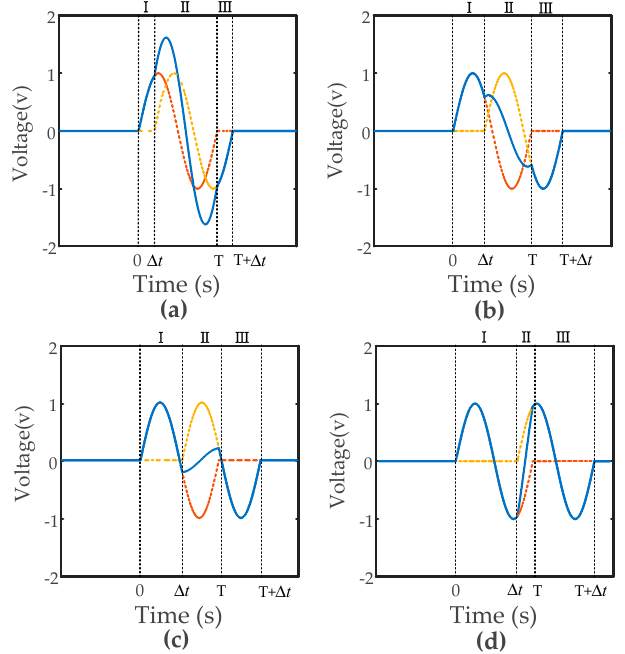
Figure 4. Four typical superposition states: under di ff erent situations: ( a ) ∆ t ∈ [ 0, T /4 ) ; ( b ) ∆ t ∈ [ T /4, T /2 ) ; ( c ) ∆ t ∈ [ T /2, 3 T /4 ) ; ( d ) ∆ t ∈ [ 3 T /4, T )